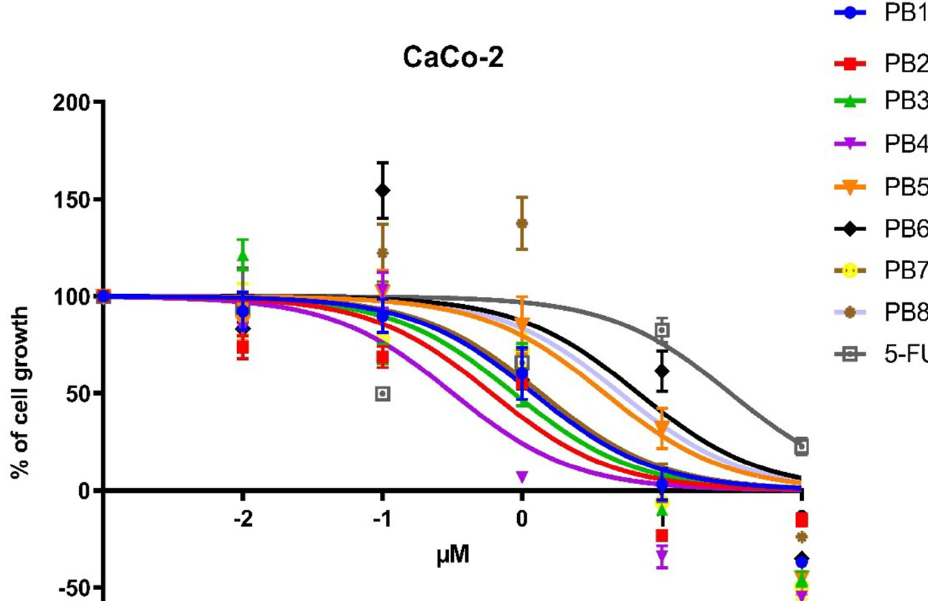
Figure 2. Dose–response curves of antiproliferative activities of PBn compounds and 5-FU against CaCo-2 cells after 24-h treatment.